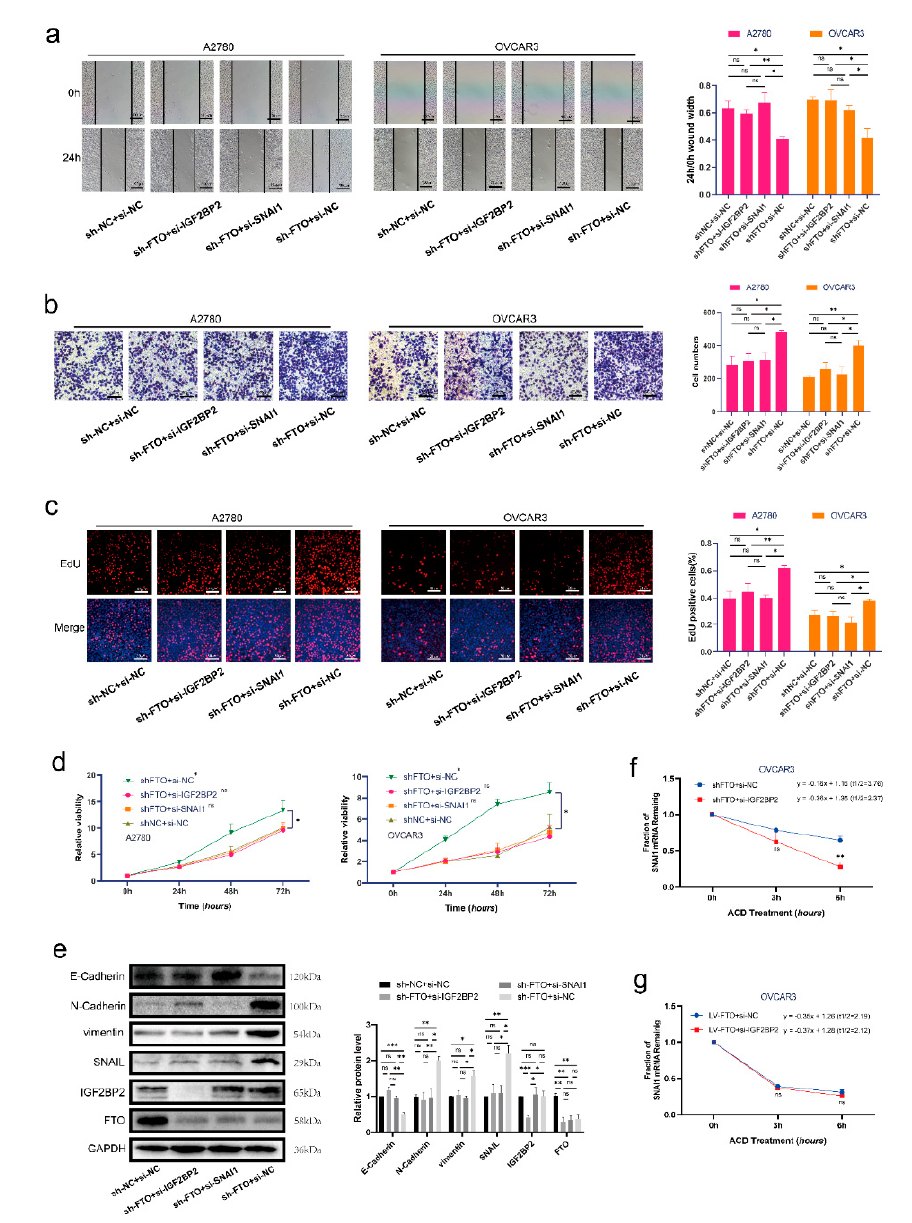
Figure 6. FTO exerts anti-tumour roles of EOC by inhibiting SNAI1 with the help of IGF2BP2. Wound healing ( a ), Transwell ( b ), EdU ( c ) and CCK-8 ( d ) assays were used to detect the migration, invasiveness, proliferation and viability of A2780 and OVCAR3 cells, respectively. ( e ) Pro- tein levels of FTO, IGF2BP2, SNAI1, N − cadherin, E − cadherin and vimentin in OVCAR3 cells, detected by Western blotting. ( f , g ) SNAI1 mRNA stability in OVCAR3 cells was detected by ACD assay. The data represent the results of three independent replicates. Data are presented as mean ± SD. ns, not significant; * p < 0.05; ** p < 0.01; *** p < 0.001. The uncropped blots are shown in Supplementary Materials File